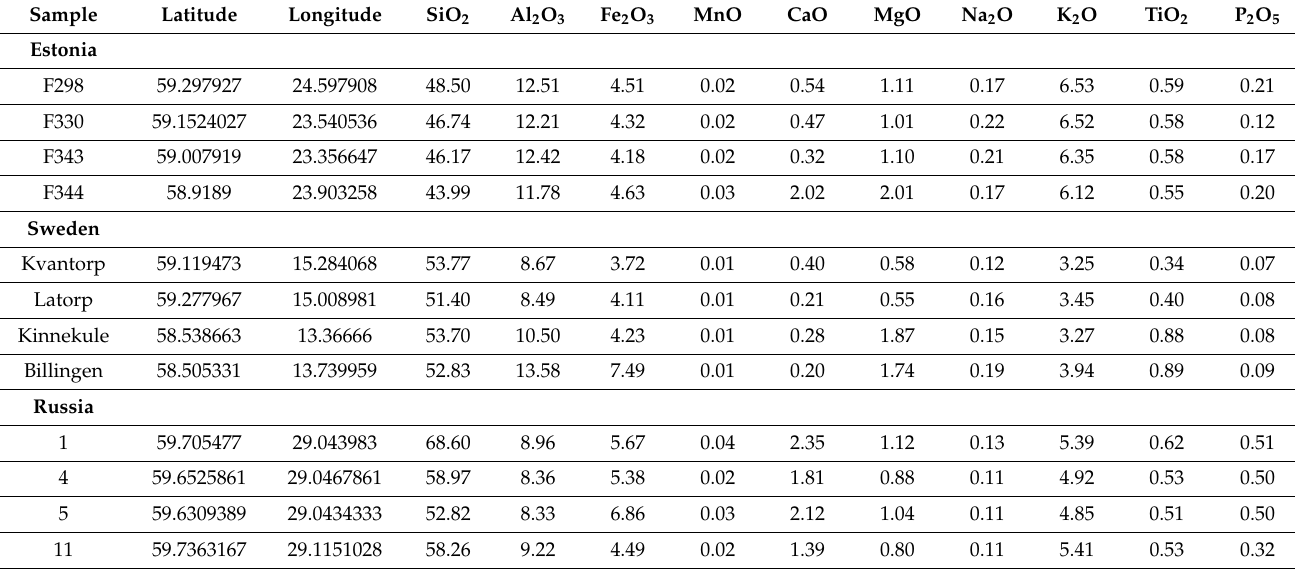
Table 1. Average major element concentrations (in wt%) of representative black shale drill cores in Estonia and Russia, and outcrops in